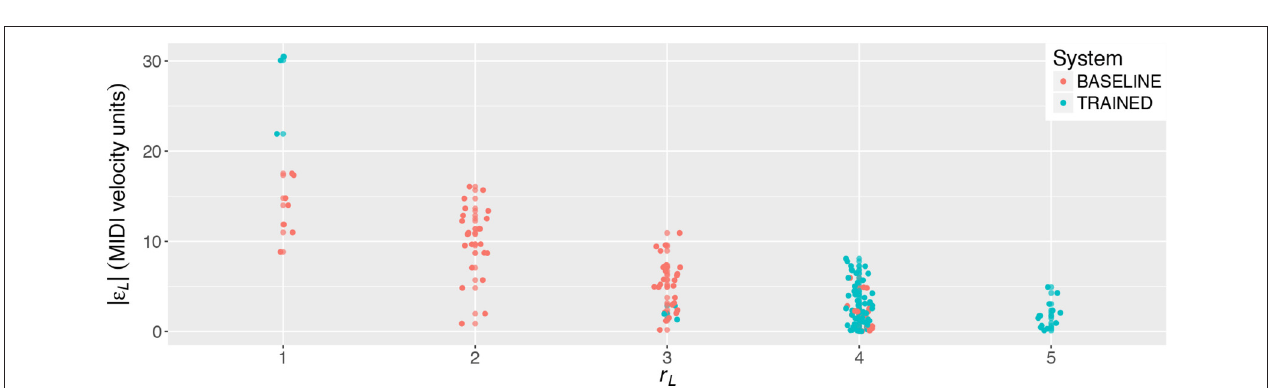
FIGURE 7 | Ratings for loudness control ( r L ) provided by participants at the end of loudness and combined tasks.